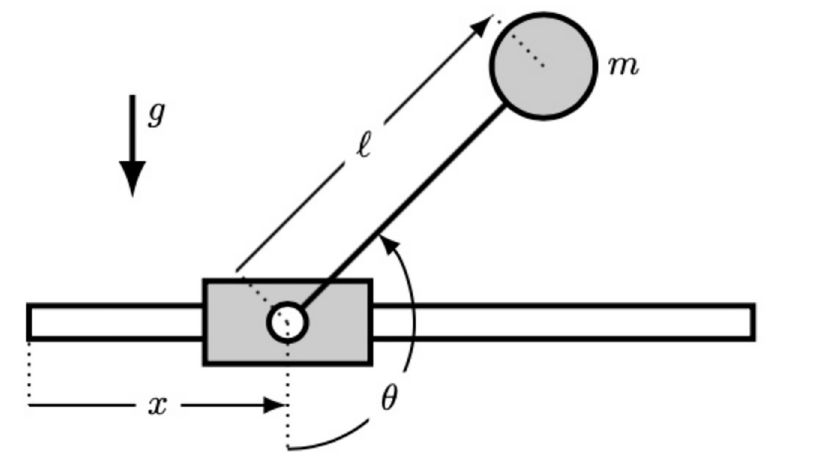
Fig 1. Sketch of the inverted